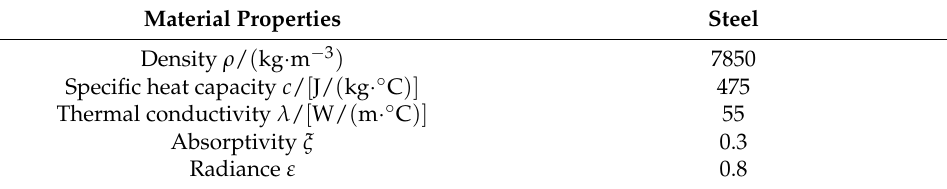
Table 2. Meteorological Parameters for Four